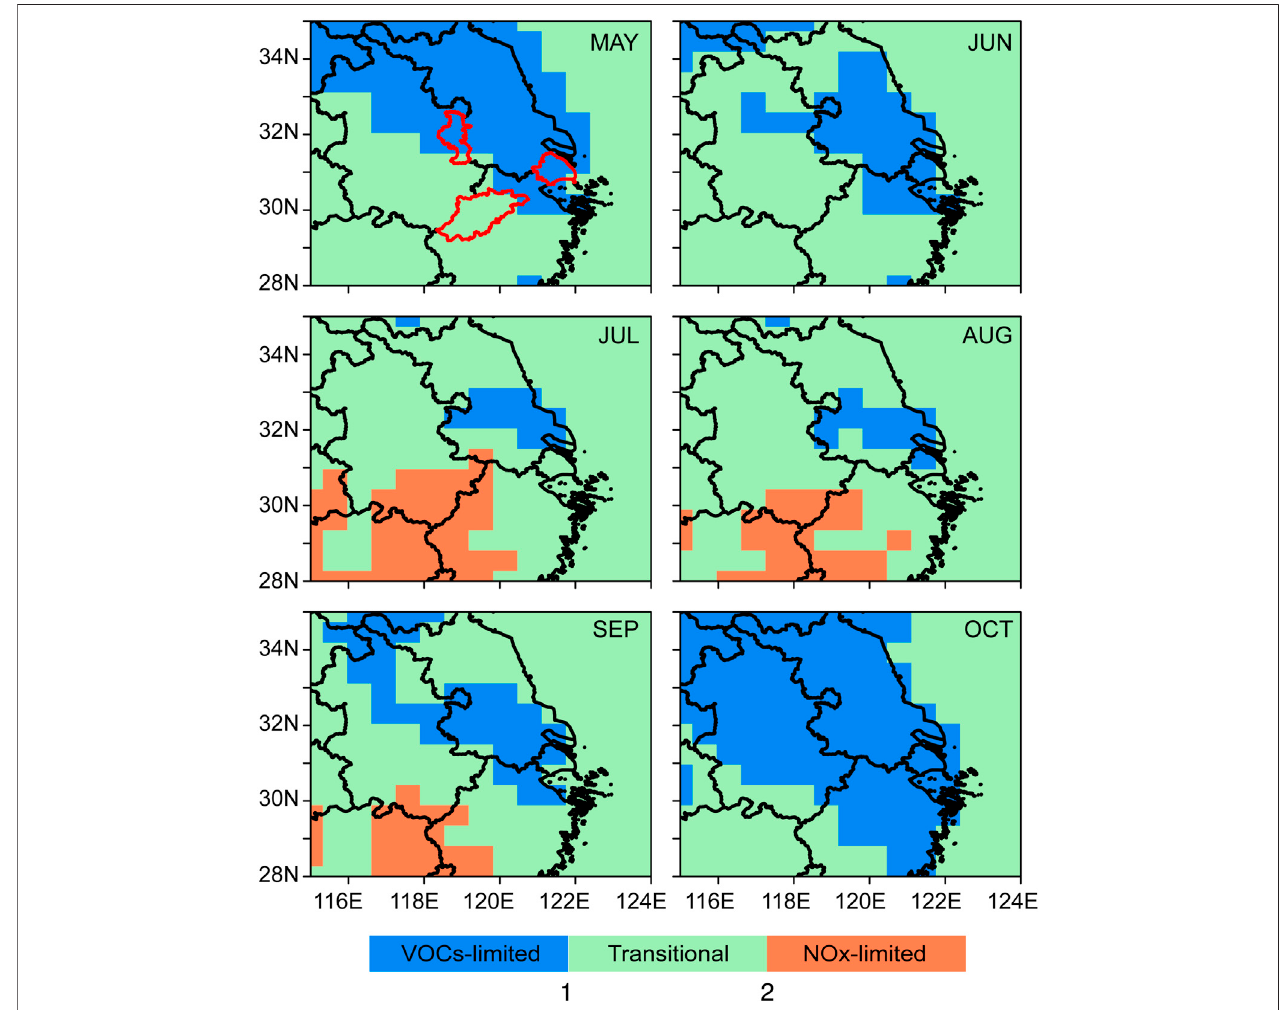
FIGURE 7 | Sensitivity regimes of ozone – NO x – VOCs de fi ned by HCHO/NO 2 ratios (FNR) in the Yangtze River Delta (YRD) region from May to October 2017. Red enclosed areas indicate Nanjing, Shanghai, and Hangzhou, respectively.